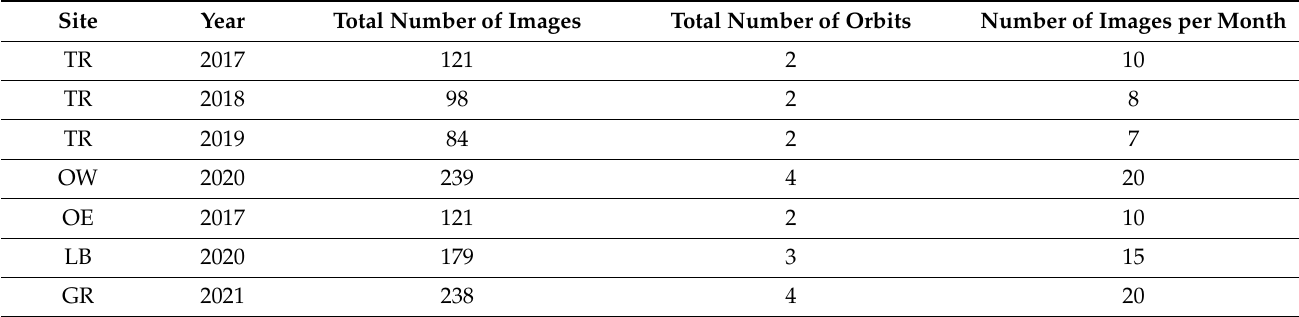
Table 2. The number of available S1 images per site and